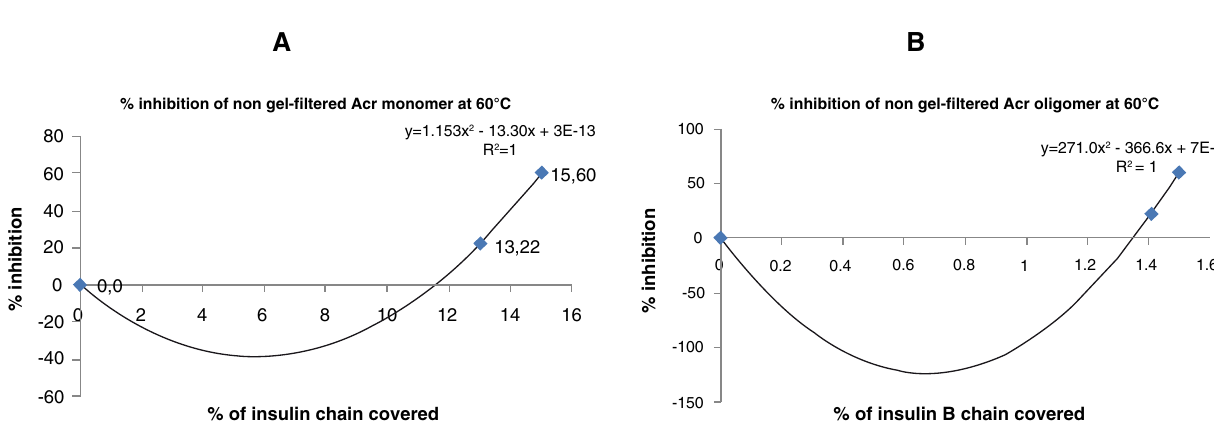
Figure 3. Chaperone activity of Acr non gel filtered versus % of insulin B chain covered. ( a ) A polynomial plot was used to plot percentage inhibition of non-gel-filtered α -crystallin (Acr) monomers against percentage of of molecules of the insulin B chain covered at 60°C. ( b ) A polynomial plot was used to plot percentage inhibition of non-gel-filtered Acr oligomer versus the percentage of molecules of insulin B chain covered at 60°C. ( c ) The percentage inhibition was replotted versus percentage of molecules of insulin B chain at 60°C by calculating the molecules of Acr based on the proportion of oligomers obtained from Native-PAGE analysis at 37°C.